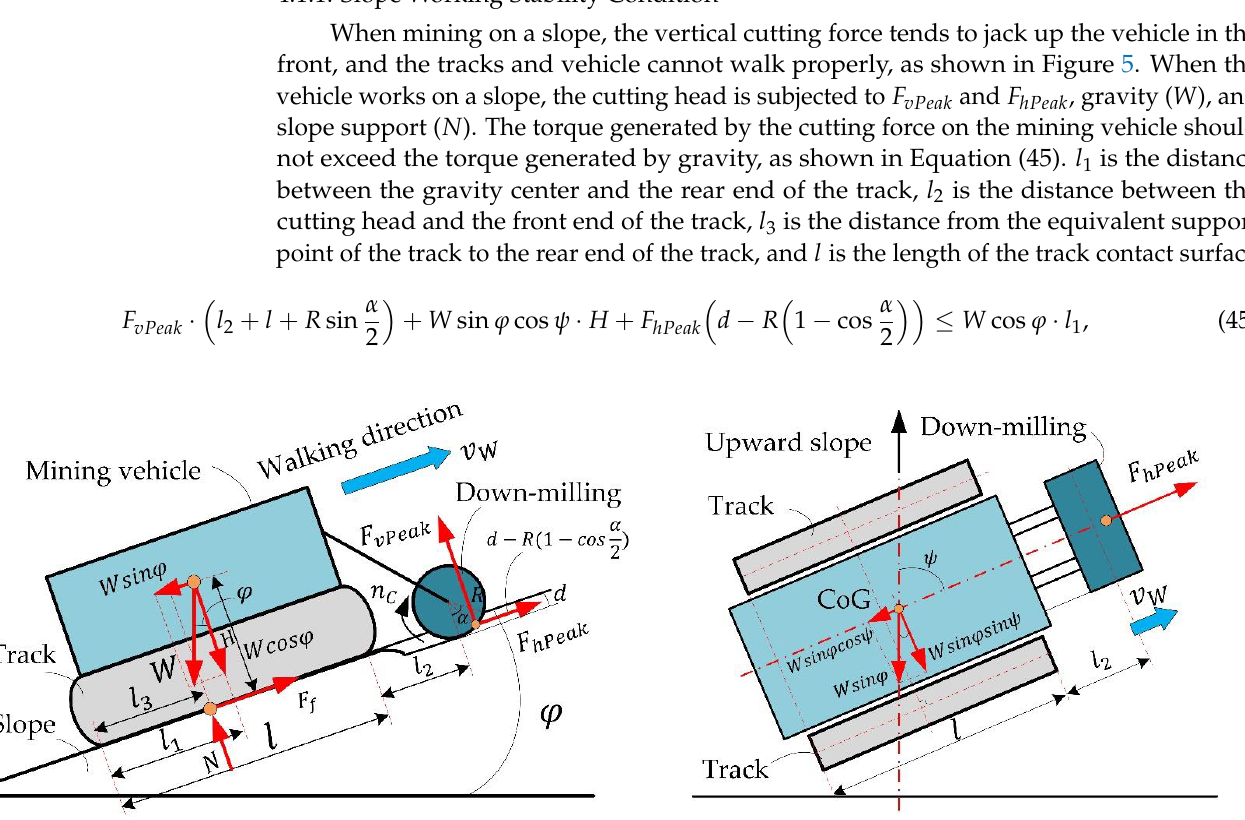
Figure 5. Slope stability diagram of mining vehicle with down-milling cutting head.